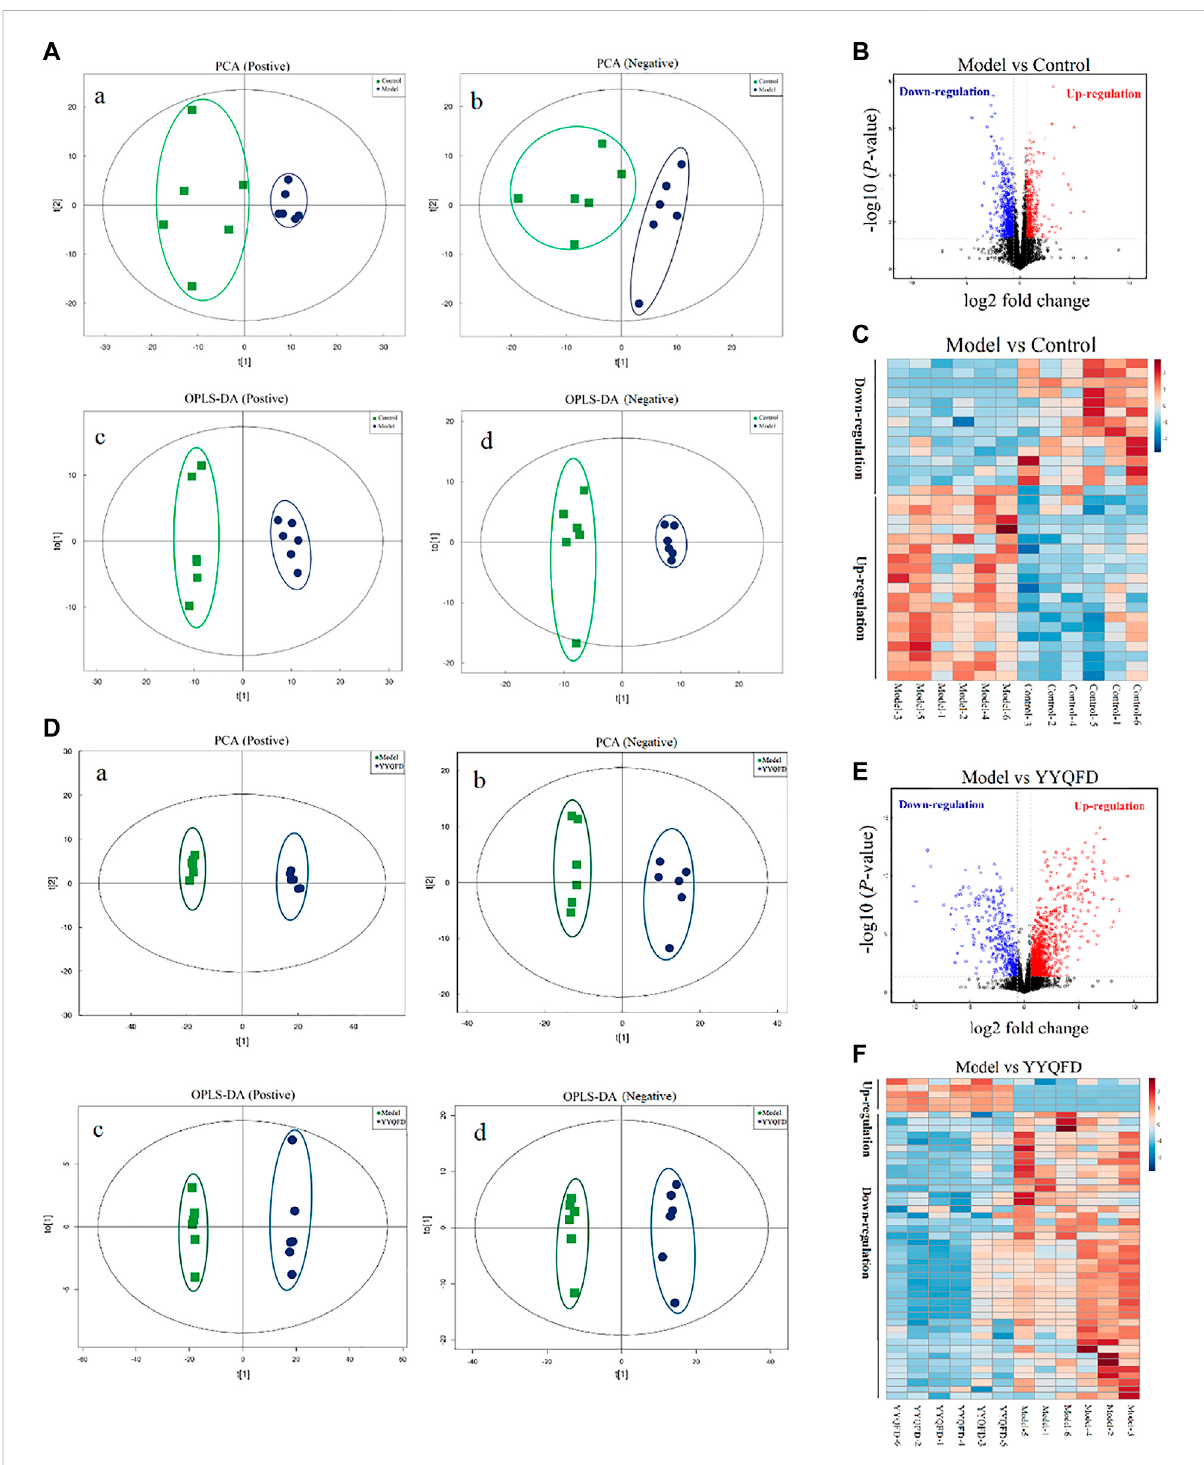
FIGURE 3 The effect of PM 2.5 exposure and YYQFD intervention on metabolomic pro fi les in lung tissues (A,B and C) Model group vs. Control group (D,E and F) YYQFT group vs. Model group (Aa)and (Da) PCA scatter map of lung metabolites in positive ion mode (R 2 X = 0.517 and 0.751) (Ab) and (Db) PCA scatter map of lung metabolites in negative ion mode (R 2 X = 0.539 and 0.522) (Ac)and (Dc) OPLS-DA scatter map of lung metabolites in positive ion mode (Q 2 = 0.876 and0.990) (Ad) and (Dd) OPLS-DA scatter map of lung metabolites in negative ion mode (Q 2 = 0.817 and 0.963) (B) and (E) Volcano plots of detected metabolites (C) and (F) Heatmap analysis of signi fi cantly differentially expressed